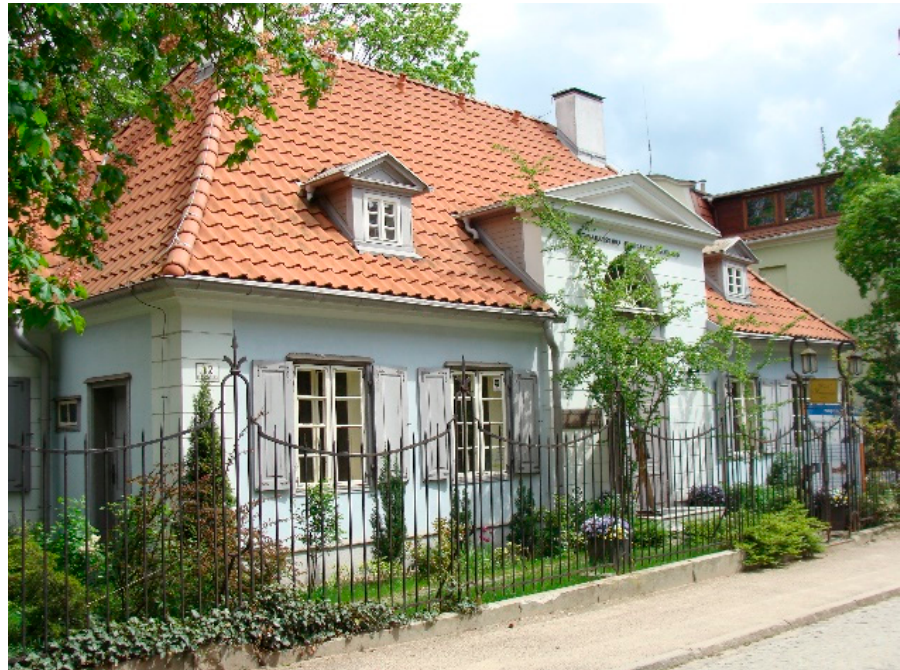
Figure 1. Sierakowski Manor House in Sopot. Source: A. Taraszkiewicz. In 1823, a former major of Napoleon’s army, Jean Georg Haffner, a doctor by profession, bought land in Sopot and built the first bathing establishment and spa house. This event